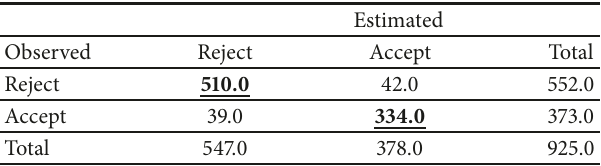
Table 8: Comparison of estimated and observed values of FMLR-2